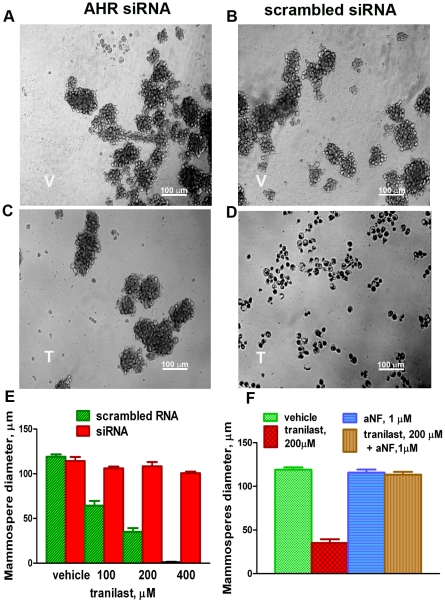
Tranilast's anti-mammosphere effect is mediated through AHR stimulation.A–D. Mammospheres formed by MDA-MB-231-derived D-CSCs, transfected with AHR-targeted (A, C) or scrambled siRNA (B, D) were treated with 200 µM tranilast (C, D) or with vehicle (A, B) for 48 h. T =  tranilast; V =  vehicle. Tranilast dissociated the mammospheres formed from cells expressing AHR (scrambled siRNA), but had no effect on cells with AHR knockdown (AHR siRNA), demonstrating the AHR is required for this tranilast effect. E. The diameter of mammospheres as a function of the concentration of tranilast in AHR-expressing versus knockdown cells. F. Tranilast's anti-mammosphere effect was completely blocked the AHR antagonist aNF, further confirming the requirement of the AHR. The data is representative of two independent experiments.